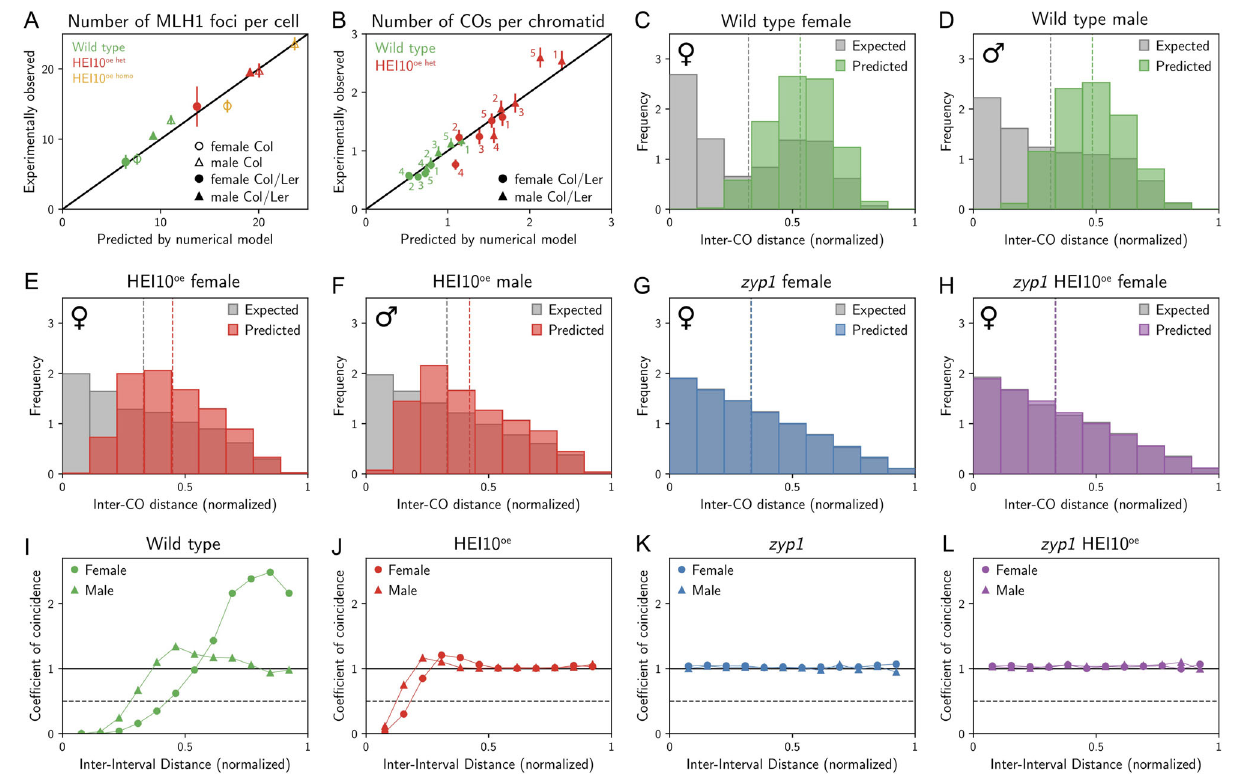
Fig. 6 | A coarsening model for crossover designation explains the measured data. A Number of MLH1 foci predicted by the model compared to the experi- mental measurements shown in Fig. 1B. Error bars denote 90% con fi dence of the mean. B Number of COs per chromatid predicted by the model compared to the experimental measurements shown in Fig. 1D. The respective chromatids are labeled and error bars denote 90% con fi dence of the mean. C – H Predicted